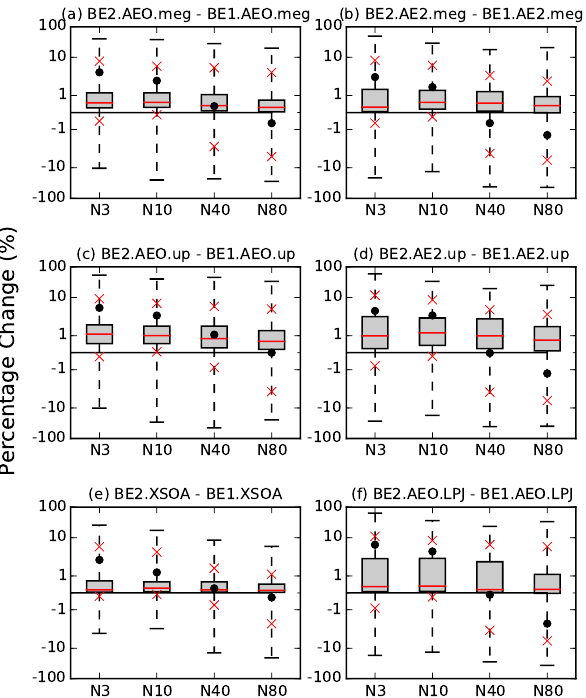
Figure 10. Global percent changes in N3, N10, N40, and N80 for biogenic emissions from 1000 to 2000 on a logarithmic scale for the simulations (a) BE2.AEO.meg–BE1.AEO.meg, (b) BE2.AE2.meg–BE1.AE2.meg, (c) , BE2.AEO.up–BE1.AEO.up, (f) BE2.AEO.LPJ–BE1.AEO.LPJ. The black dots indicate the global mean, the red line is the global median, the grey boxes are the interquartile range, the whiskers are the global maximum and min- imum changes and the red Xs indicate the 5th and 95th percentiles (see Table